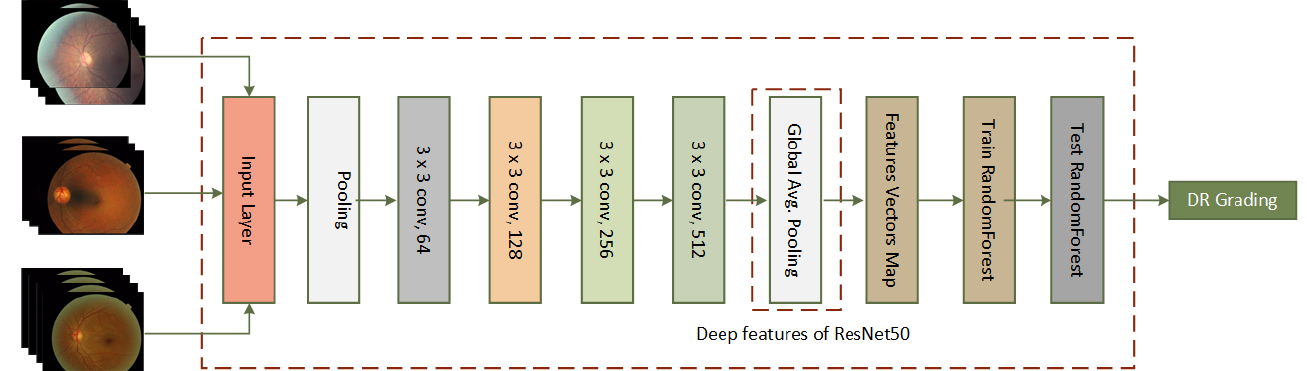
Figure 4. The proposed architecture using deep features of ResNet-50 in combination with a Random Forest